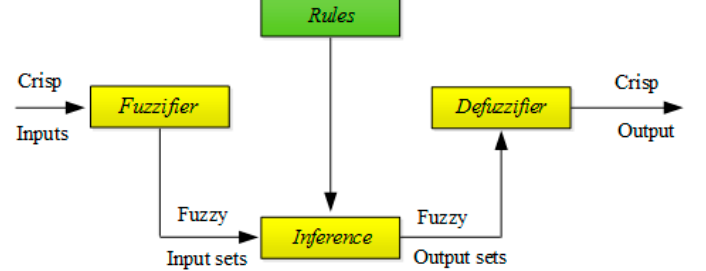
Figure 6. Basic fuzzy logic systems architecture.